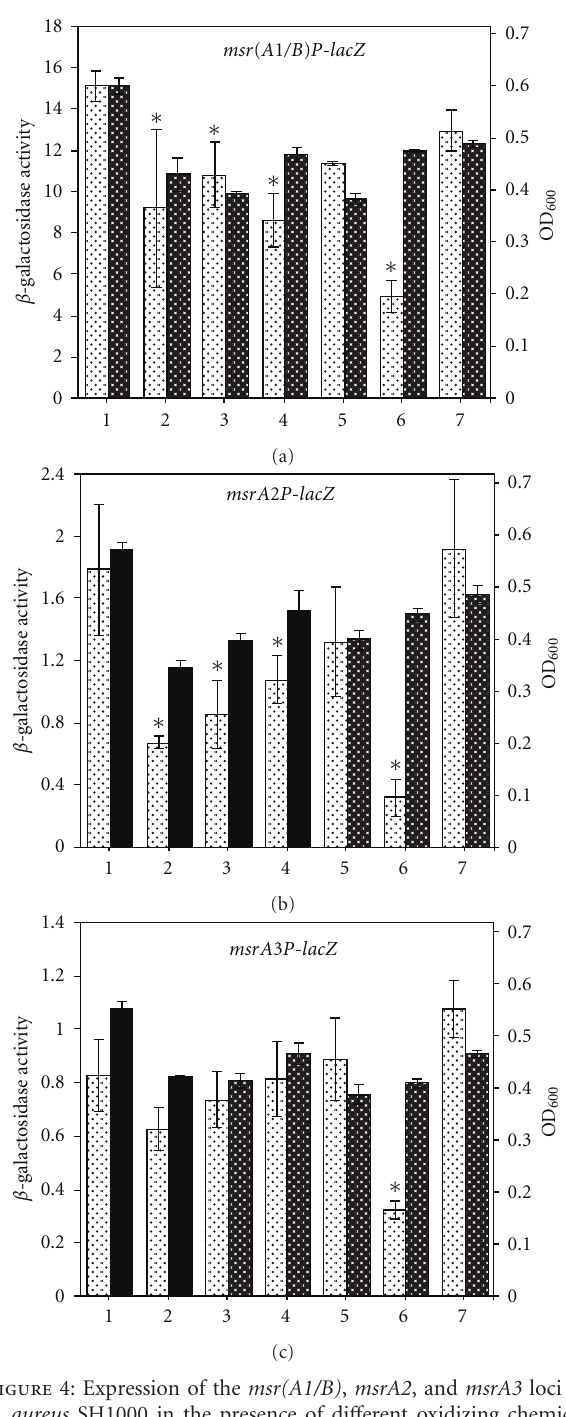
Figure 4: Expression of the msr(A1/B) , msrA2 , and msrA3 loci in S. aureus SH1000 in the presence of di ff erent oxidizing chemical agents. Cultures grown to OD 600 of 0.3 at 37 ◦ C were treated separately with the following stresses for 1h: diamide (5mM) (2), N-ethylmaleimide (NEM) (0.05mM) (3), methyl viologen (MV) (20mM) (4), menadione (MD) (0.05mM) (5), cumene peroxide (CuOOH) (0.0125%) (6), and sodium nitroprusside (SNP) (5mM) (7). β -galactosidase activity ( lighter bar ) and growth (OD 600 ) ( darker bar ) were subsequently determined. β -galactosidase activity and growth of cells in TSB control are represented in bars 1 . Values indicate averages of data from three independent experiments ± standard deviation